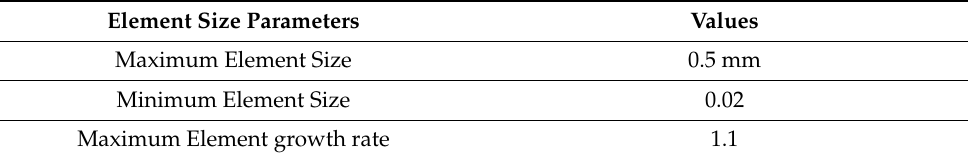
Figure 6. ( a ) The adaptive mesh used for modeling the coil, and ( b ) the convergence of coil reactance with the increasing resolution of narrow regions.